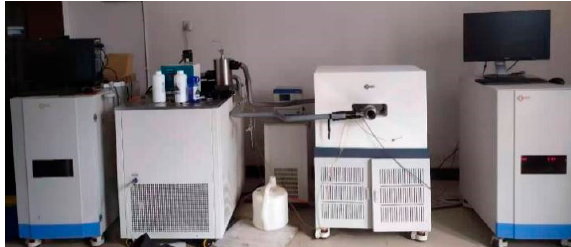
Figure 1. Low-field NMR system.